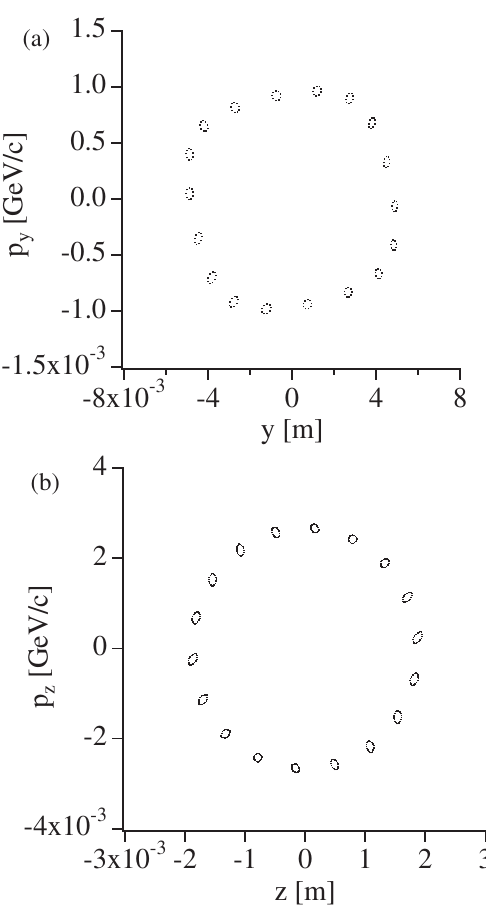
FIG. 6. (a) Horizontal and (b) vertical edge of a beam after going through 100 cells. 18 phase space positions with the amplitude of 10 (cid:2) mm mrad in one direction has 18 particles in the other